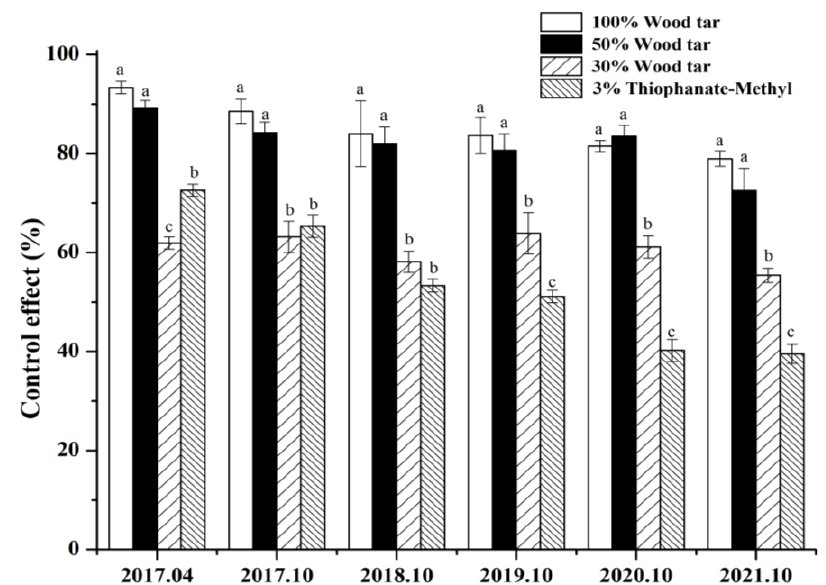
Figure 7. Field efficacy of wood tar against Valsa canker. Bars denote the stand errors. Different letters above the columns indicate significant differences according to Duncan’s multiple range test ( p < 0.05).